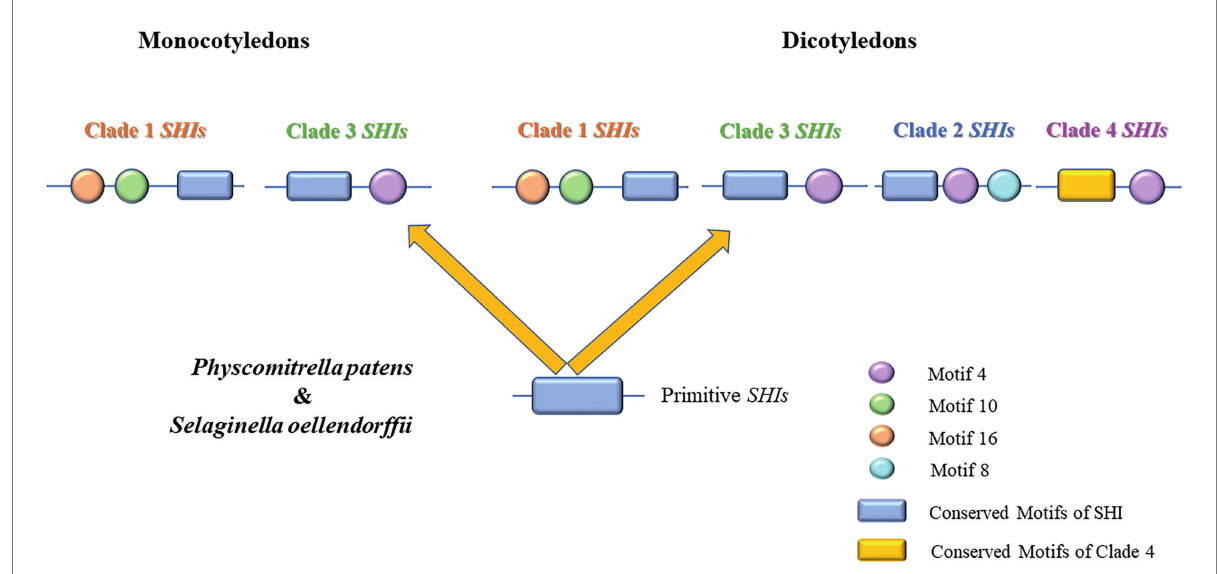
FIGURE 12 Evolution scenario of the SHI/STY gene family in land plants. In Physcomitrella patens and Selaginella oellendorffii , the SHI/STY gene family emerged. The SHI/STY gene family is formed by adding different motifs at both ends of conserved domains to form Clade 1 and Clade 3 in monocotyledons. In dicotyledons, the Clade 3 gene was further duplicated and gradually evolved into three branches through loss or acquisition of new motifs (some retained the characteristics of Clade 3, some acquired motif 8 and evolved into Clade 2, while the conserved motif in Clade 4 was